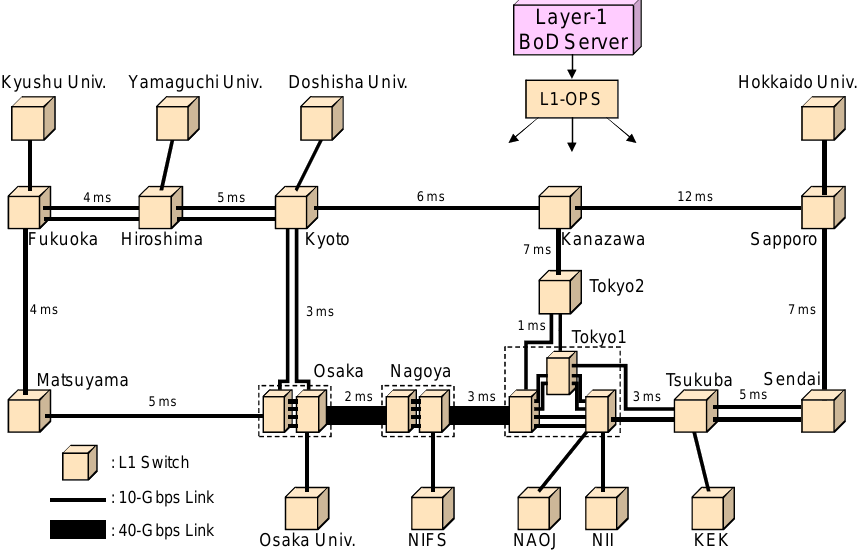
Figure 3. Core network topology and initial BoD